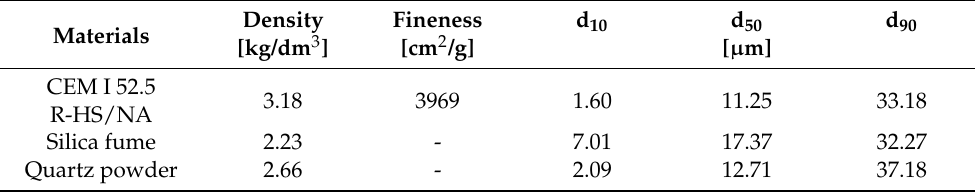
Table A1. Physical properties and grain size distribution of cement and fine aggregates.